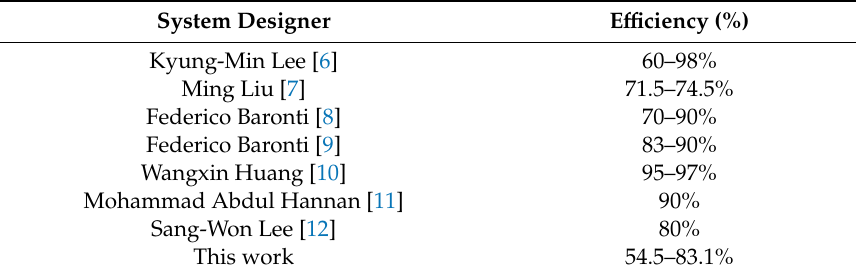
Table 3. Cell voltage of the unbalanced 6S1P battery module for the testing condition.